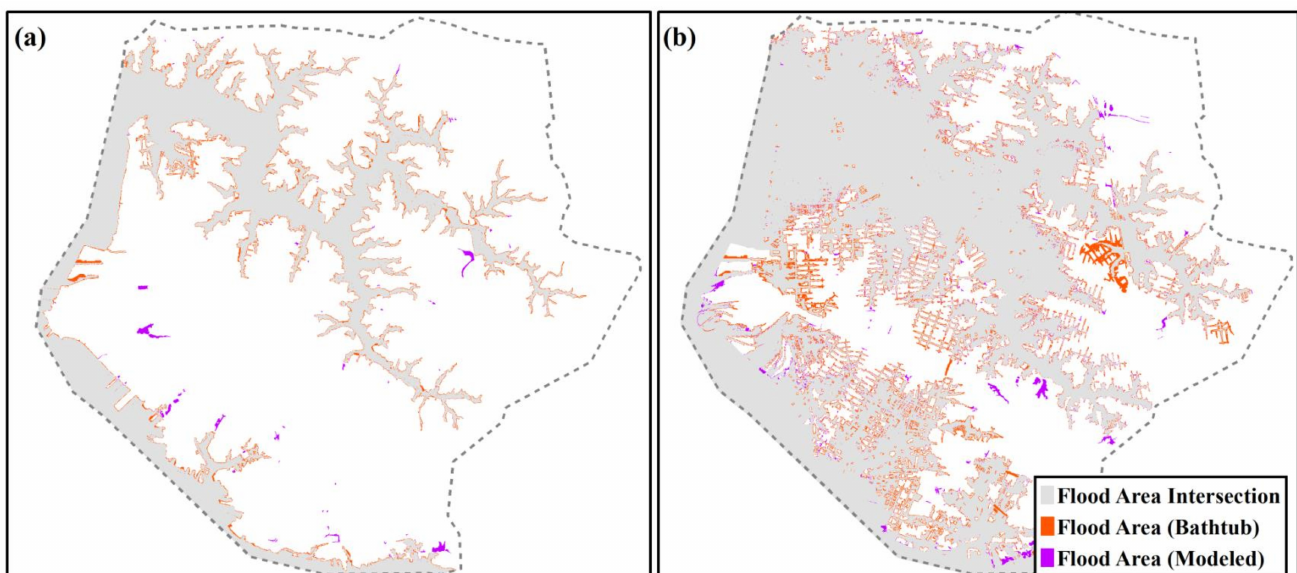
Figure 9. Demonstration of flood area estimation using the bathtub method and the coupled modeling system in two scenarios: ( a ) 10-year storm surge under the 2020 climate conditions and ( b ) 10-year storm surge under the 2070 high RSLR